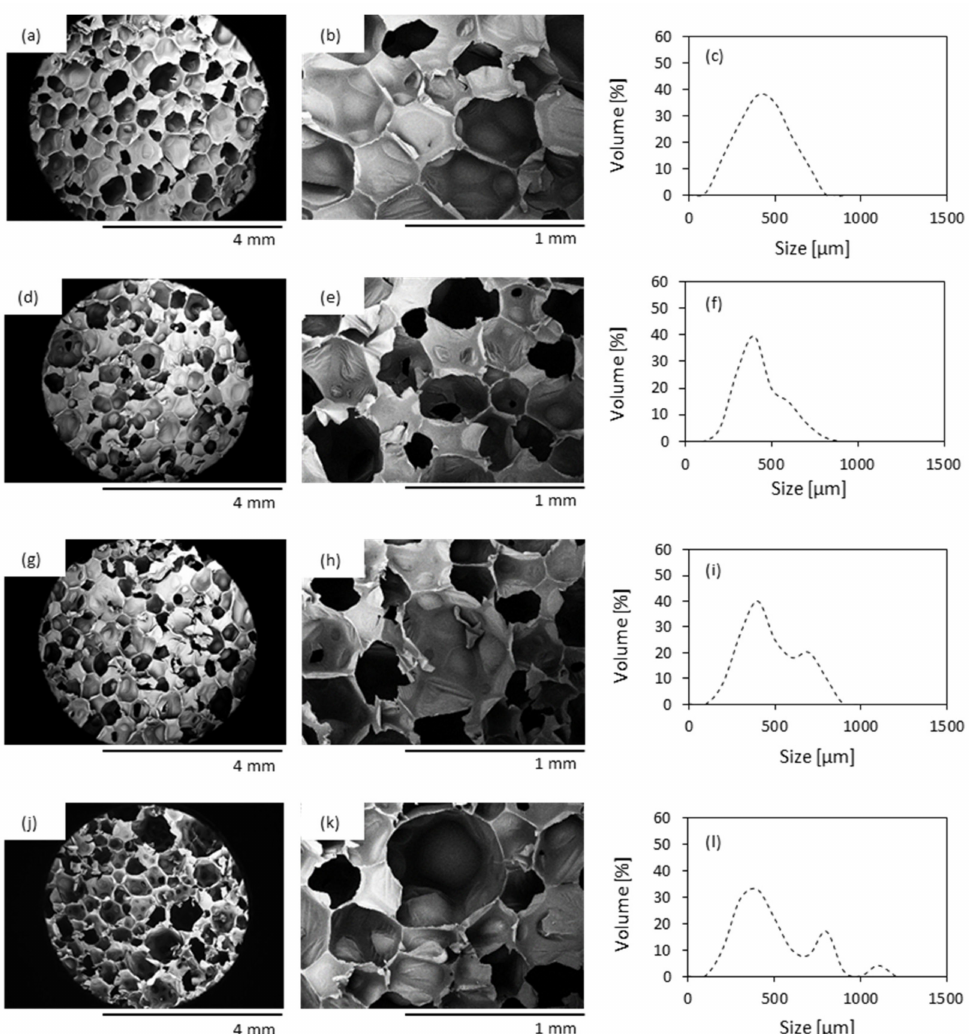
Figure 4. Optical image, SEM image and cell size distribution of ( a – c ) PUR_0, ( d – f ) PUR_HS, ( g – i ) PUR_HS / SO and ( j – l ) PUR_HS /